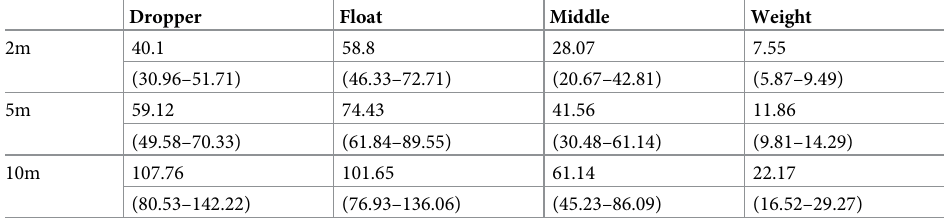
Table 2. Summary table of time taken in seconds for TDRs set at different longline locations to reach specific water depths. Dropper Float Middle Weight 2m 40.1